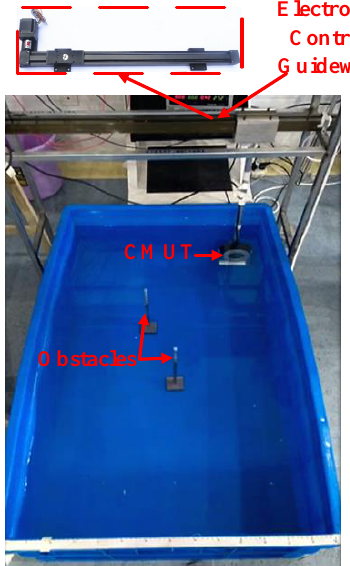
Figure 8. Linear scanning imaging configuration.